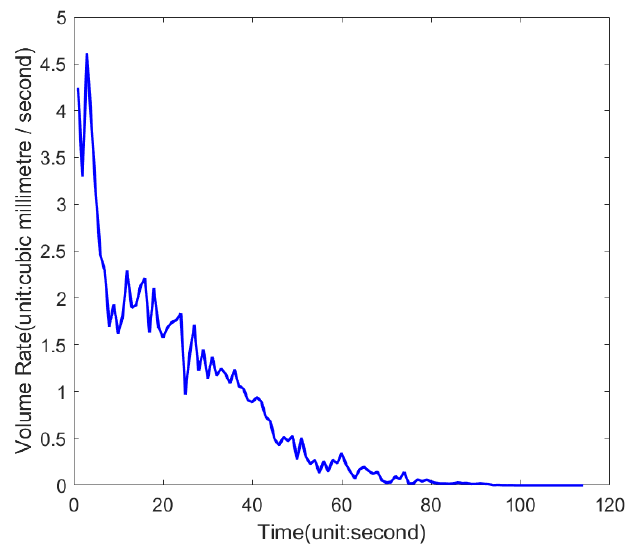
Figure 13. Volume change of silicon dioxide at each moment during the melting process in the high-temperature cell.